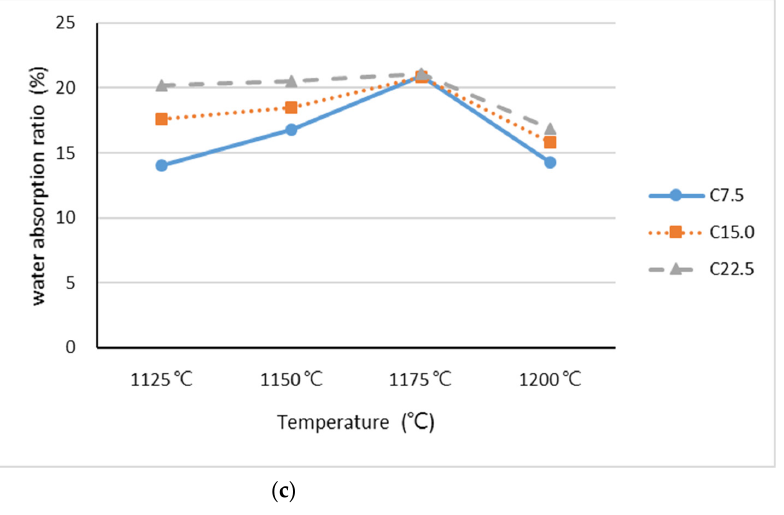
Figure 4. The 24 h water absorption ratios of lightweight aggregates at Stage I mixed with ( a ) Industrial Sludge A, ( b ) Industrial Sludge B, and ( c ) Industrial Sludge C.